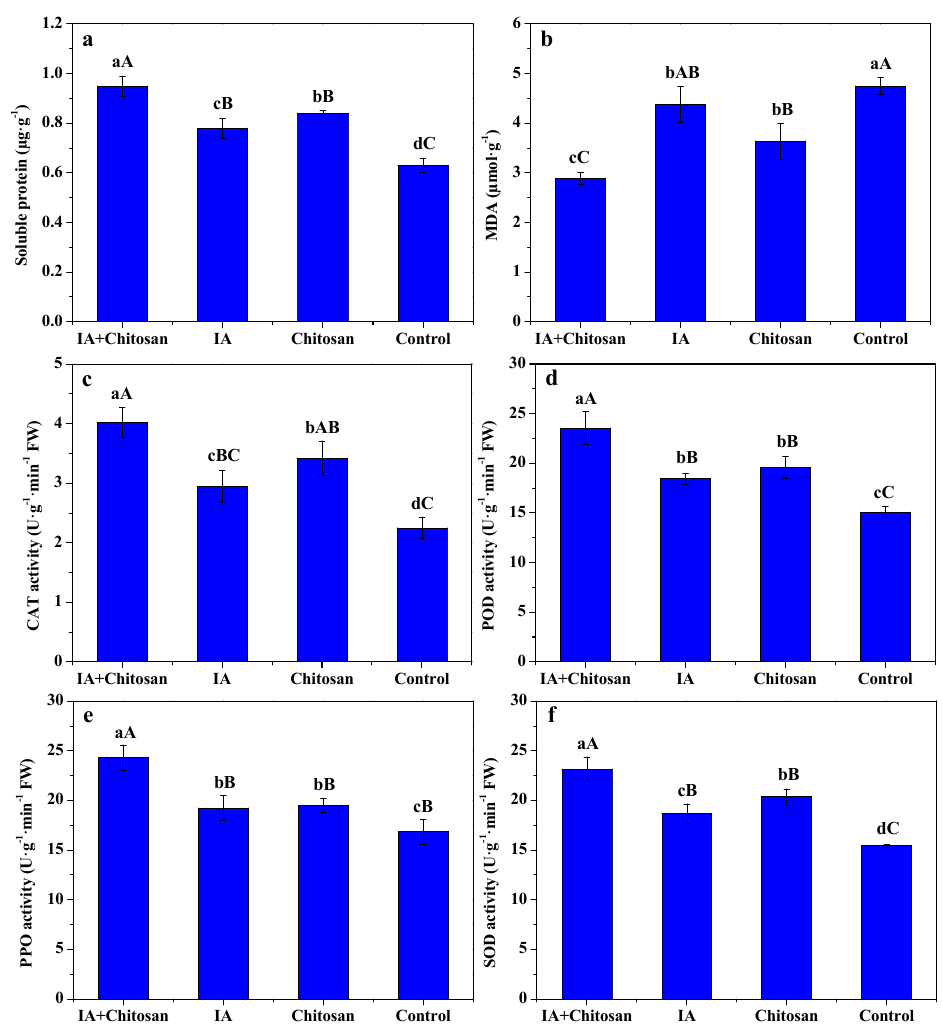
Figure 1. The effects of isopyrazam · azoxystrobin and chitosan on the soluble protein ( a ), MDA ( b ), CAT activity ( c ), POD activity ( d ), PPO activity ( e ), and SOD activity ( f ) of kiwifruit leaves. Values and error bars indicate the mean and SD of three replicates, respectively. IA is the abbreviation of isopyrazam · azoxystrobin. Different small and capital letters indicate significant differences at 5% level ( p < 0.05) and 1% level ( p < 0.01),